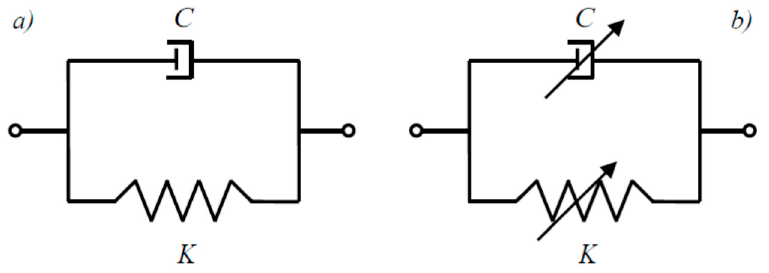
Figure 1. Rheological model: ( a ) Kelvin–Voigt; ( b ) extended Kelvin–Voigt.